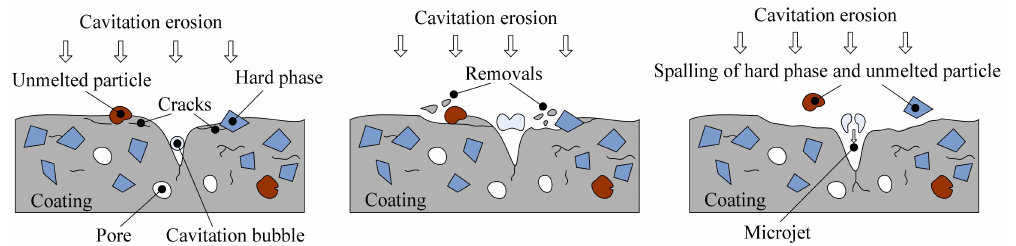
Figure 13. Schematic of the cavitation erosion